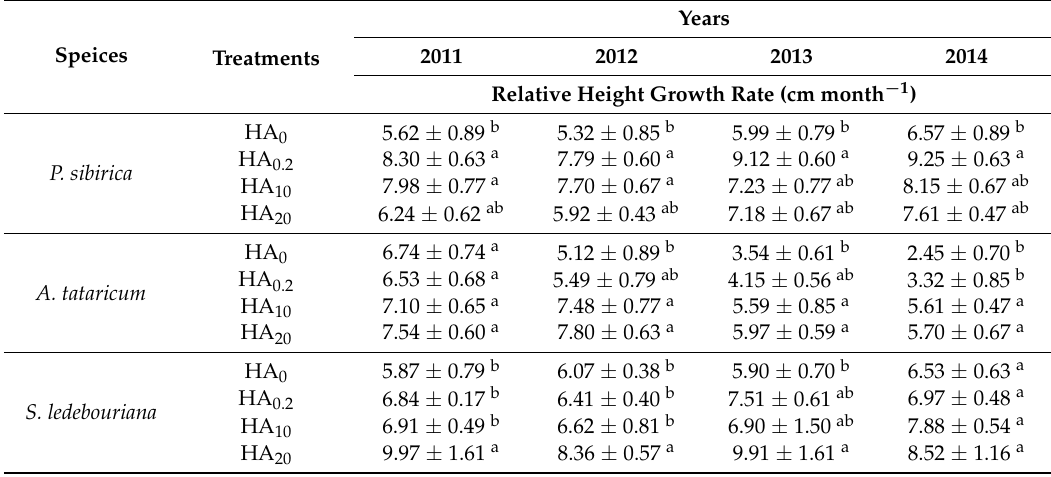
Table 2. Effect of humic fertilization on the relative height growth rate (RHGR) of Populus sibirica , Acer tataricum , and Salix ledebouriana